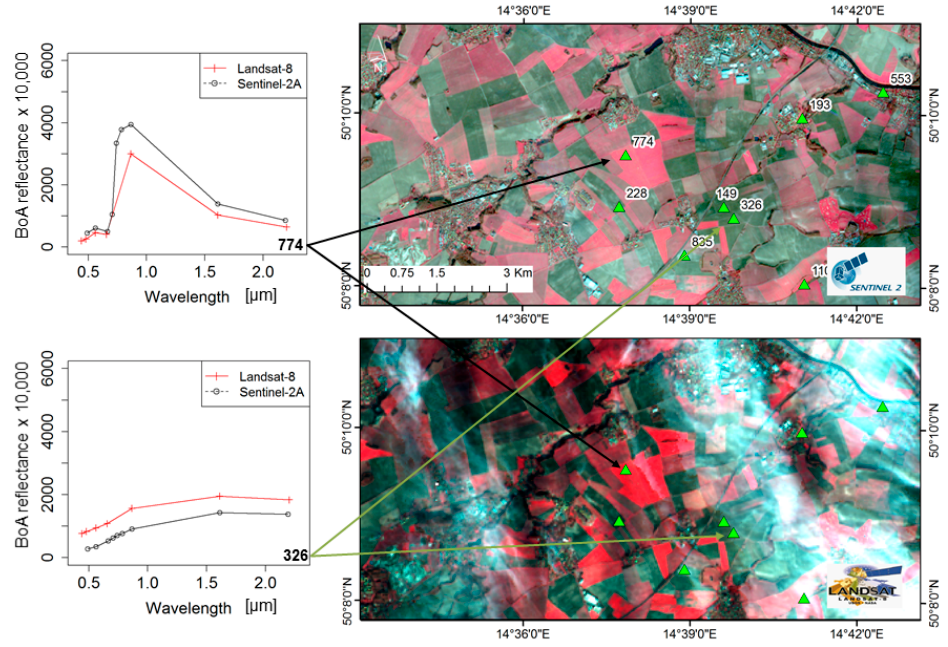
Figure 6. Examples of spectral mismatch between Sentinel-2 and Landsat-8 BoA reflectances due to undetected clouds or problems of atmospheric correction in regions adjacent to clouds. BoA reflectance values are scaled by 10,000.